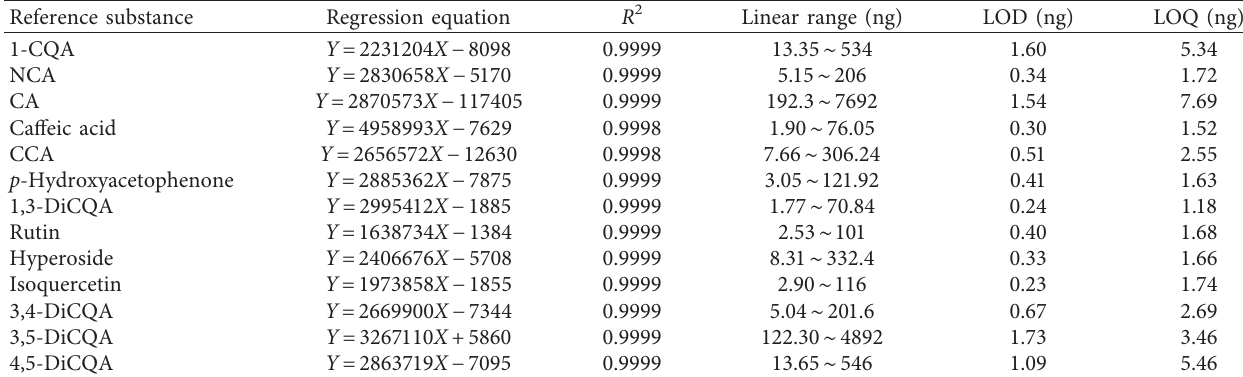
Table 2: Results of the investigation of the linear relationship, LOD, and LOQ. Reference substance Regression